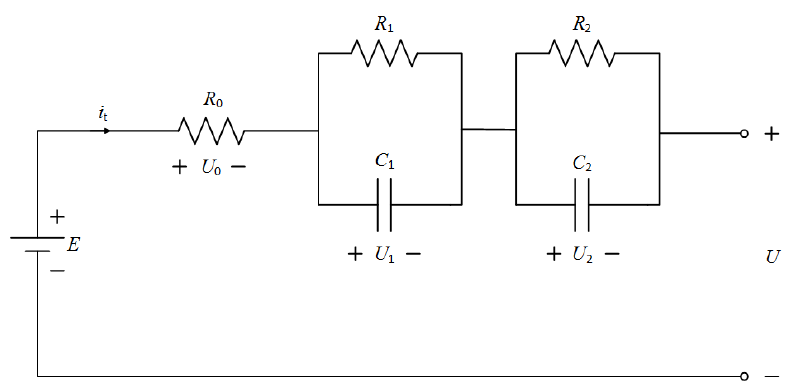
Figure 1. The circuit of the second-order RC